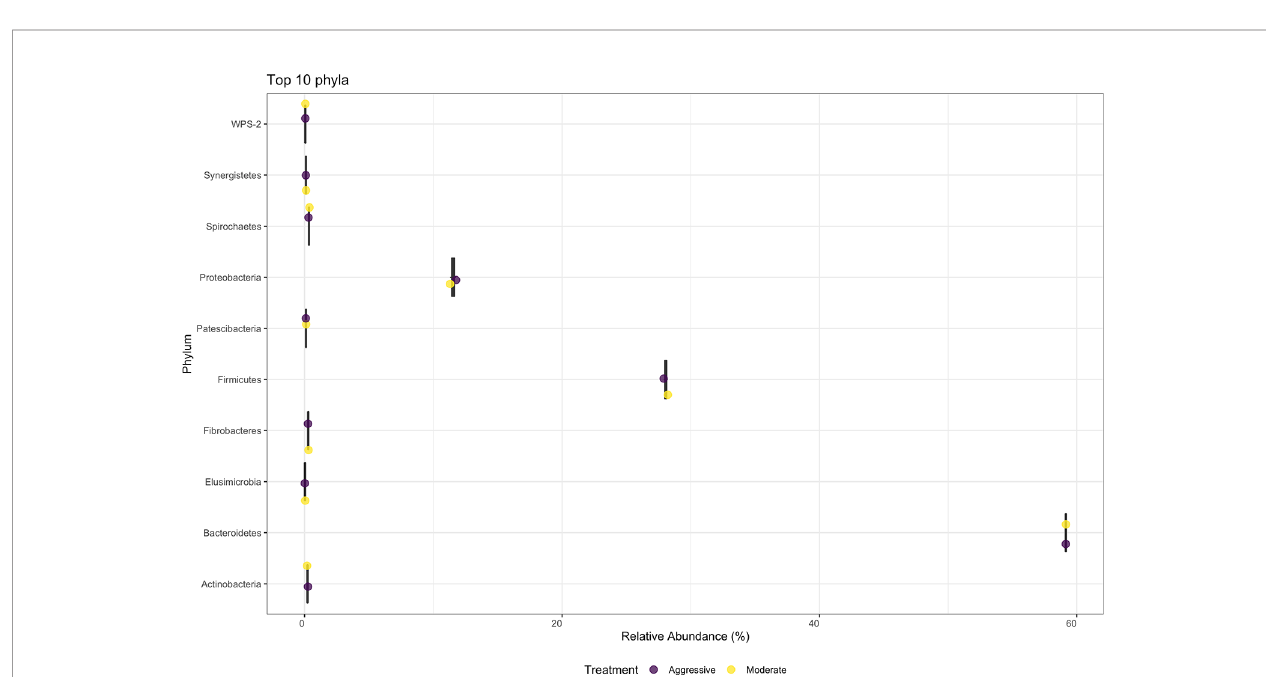
FIGURE 3 | Average relative abundance of the top ten phylum-level bacterial communities classi fi ed in ruminal fl uid between aggressive or moderate implant strategies. Mean relative abundance of bacterial communities associated with the aggressive implant strategy are represented in purple and moderate implant strategy in